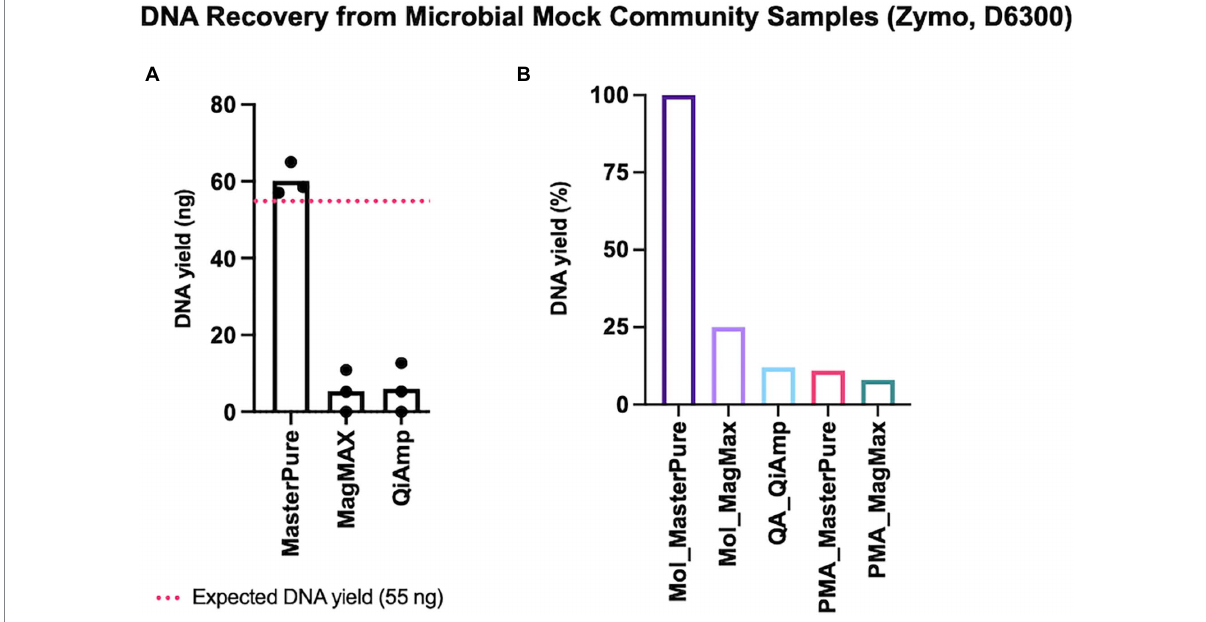
FIGURE 2 DNA recovery from mock samples. (A) Three commercial DNA extraction kits without depletion steps were tested. Estimated input was 55 ng (dashed red line). Values for individual samples are presented as dots. Bars correspond to mean values from three independent experiments. (B) Retrieved DNA yield using protocols composed of host DNA depletion and DNA extraction steps. Values were normalized to the mean yield obtained with Mol_MasterPure protocol. Bars represent retrieved mean DNA yield relative to the mean yield obtained with Mol_MasterPure